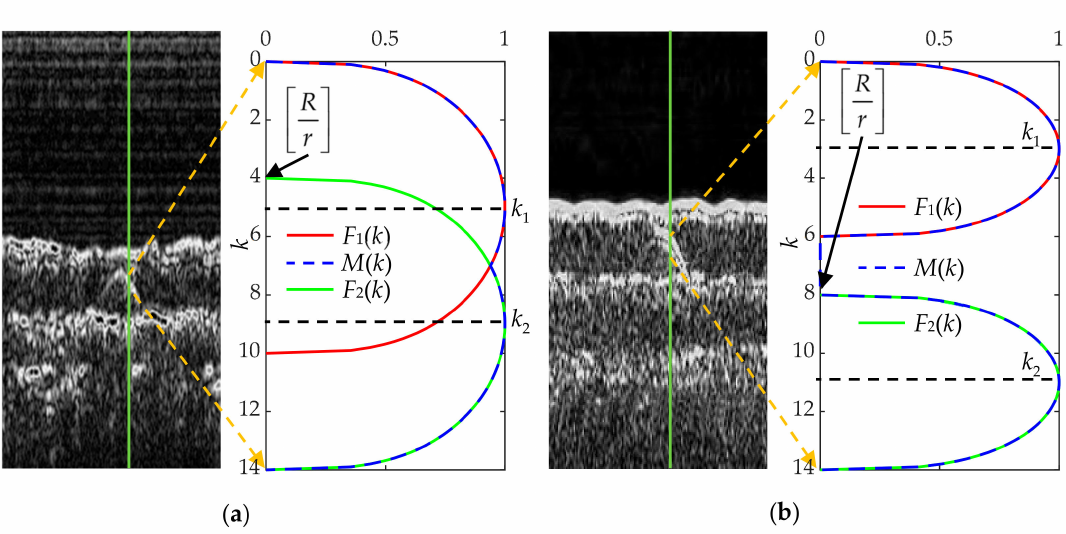
Figure 12. Simulation of the pipeline echo variation in a certain column of the image. ( a ) There is signal aliasing; ( b ) the pipeline diameter is greater than the propagation distance of sound waves within the effective pulse duration.